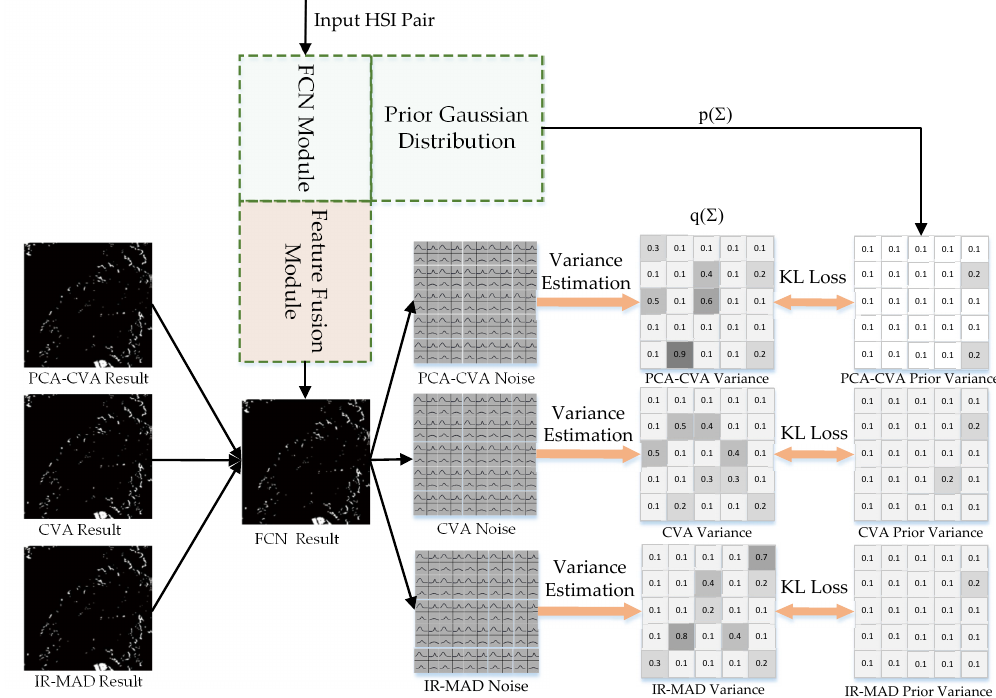
Figure 4. This figure illustrates the training details of the proposed denoising module. In this module, the latent change detection map generated by the FCN network is subtracted by the unsupervised training datasets to obtain the noise map. Then, we train this module to minimize the Kullback–Leibler (KL) divergence between the noise distribution and the prior Gaussian distribution. Finally, a noise excluded-change detection map is obtained when this module